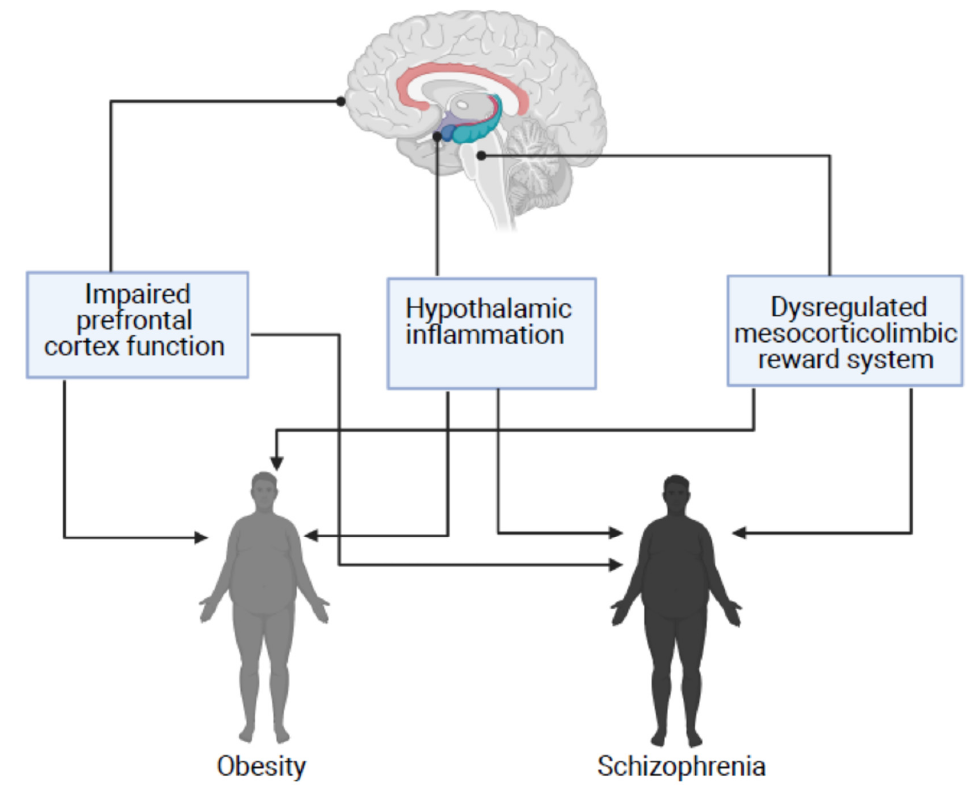
Figure 1. Three overlapping brain mechanisms in obesity and schizophrenia. Impaired prefrontal cortex function, hypothalamic inflammation and dysregulated mesocorticolimbic reward system have been implicated in the pathogenesis of obesity and have also been described as part of the neurobiology of schizophrenia.